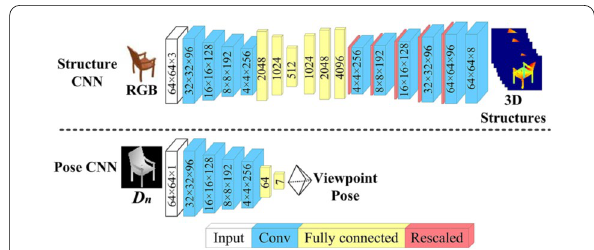
Figure 6 The neural network